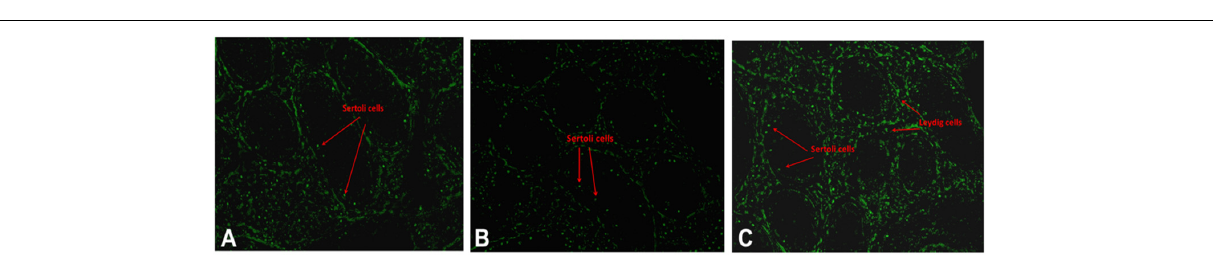
FIGURE 6 | Immunolocalization of Sertoli and Leydig cells using GATA4 in testis of exotic purebred (A) , crossbred (B) and indigenous purebred (C) males (from Tripathi et al.,